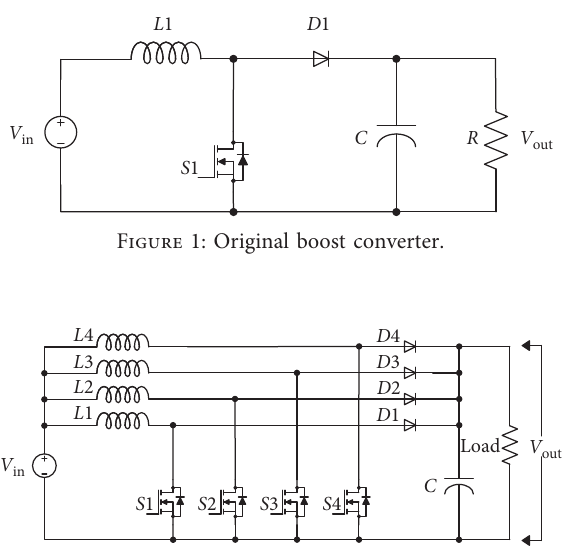
Figure 2: Four-phase interleaved boost converter circuit.